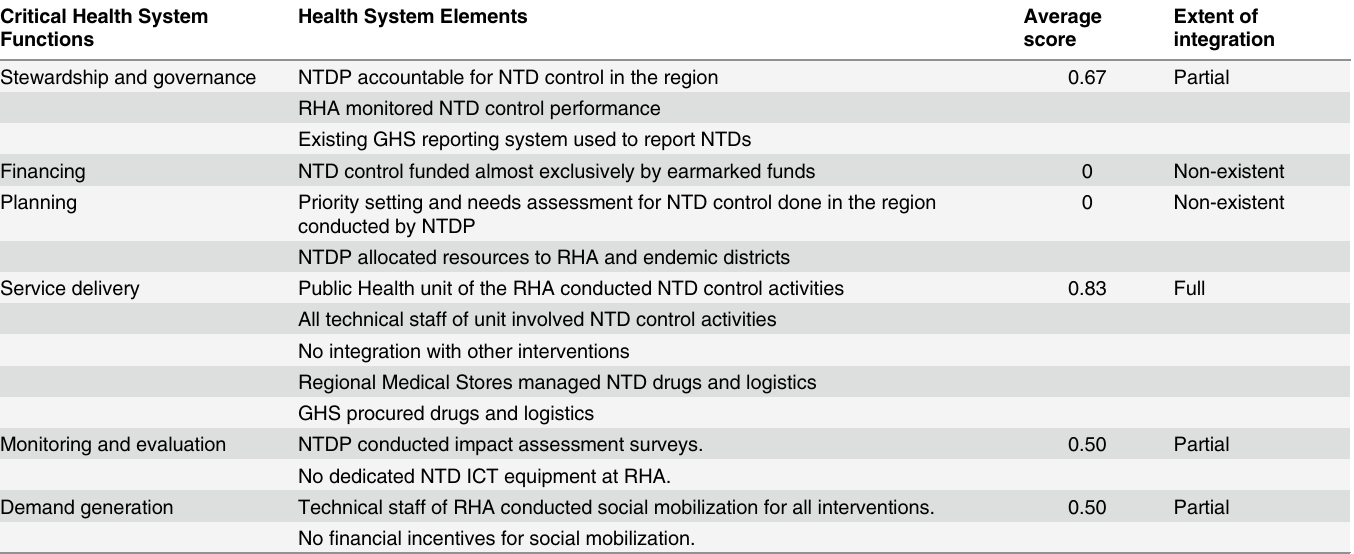
Table 3. Extent of integration of health system functions at regional level of health